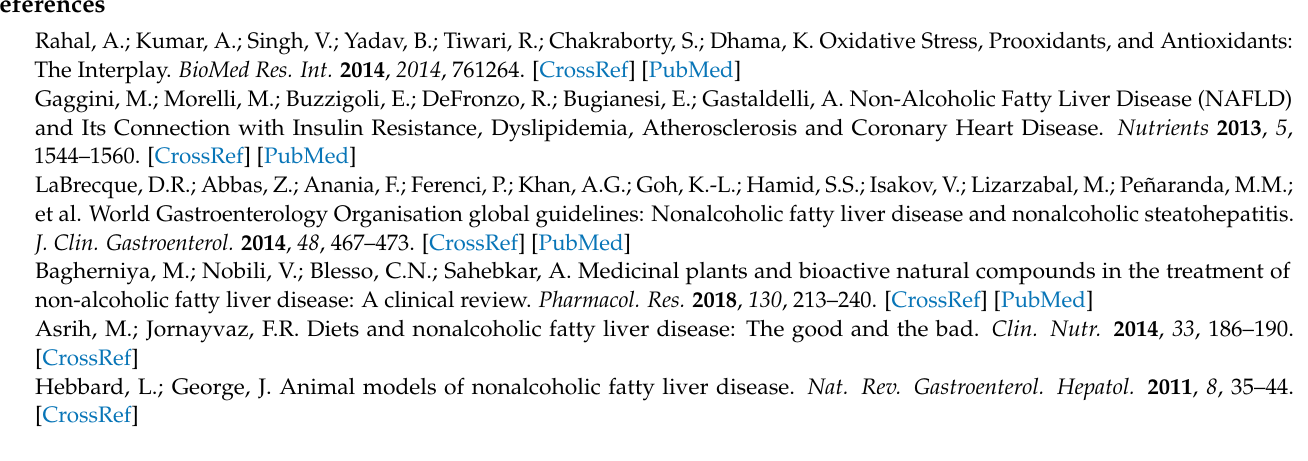
Figure S14: Dendrogram for AE compounds; Figure S15: Boxplot Diagram–Distribution and spread of IC50 values between different methods; Figure S16: Boxplot Diagram–Distribution and spread of DPPH data set for every vegetal extract group; Figure S17: Boxplot Diagram–Distribution and spread of ABTS data set for every vegetal extract group; Figure S18: Boxplot Diagram–Distribution and spread of FRAP data set for every vegetal extract group; Figure S19: Superposition of docking poses (pink) on initial/crystal conformations (green); Figure S20: Standard curve of rutin (TF); Figure S21: Standard curve of chlorogenic acid (TPA); Figure S22: Standard curve for tannic acid (TP); Figure S23: Calibration curve for ascorbic acid (vitamin C)-Antioxidant action in 50% Ethanol; Figure S24: Calibration curve for ascorbic acid (vitamin C)-Antioxidant action in 20% Ethanol; Table S1: Validation parameters of the LC-HRMS analytical method; Table S2: Monitored compounds by full-scan-HRMS analysis and MS-MS analysis based on analytical